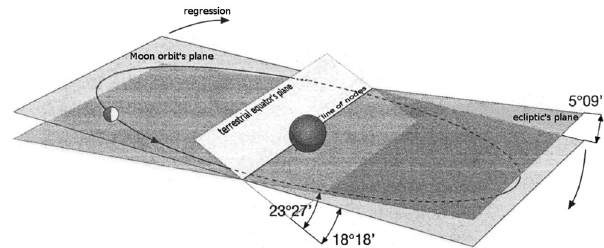
FIG. 11. Moon orbit.